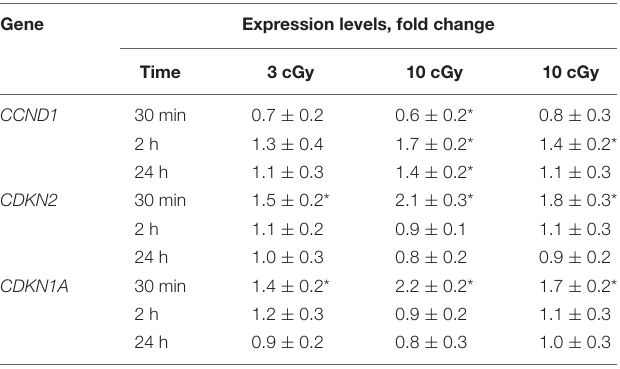
mRNA level – average expression of genes in treated MSCs compared to control (for three biological replicates). Reference gene – TBP. *p < 0.001, nonparametric U test